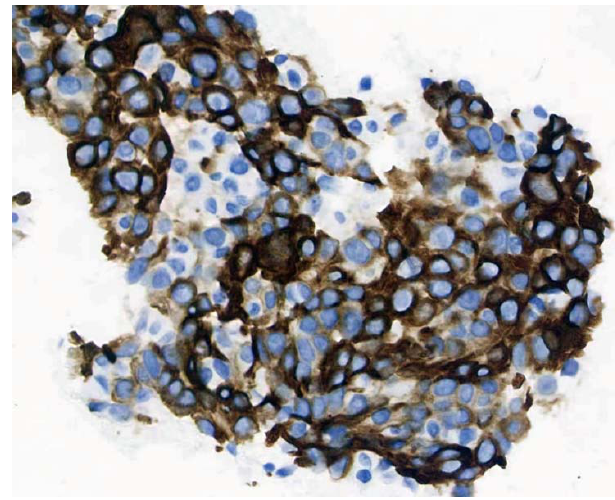
Figure 4. Immunohistochemistry result of tumor cells (40 × 10): CK7(+).